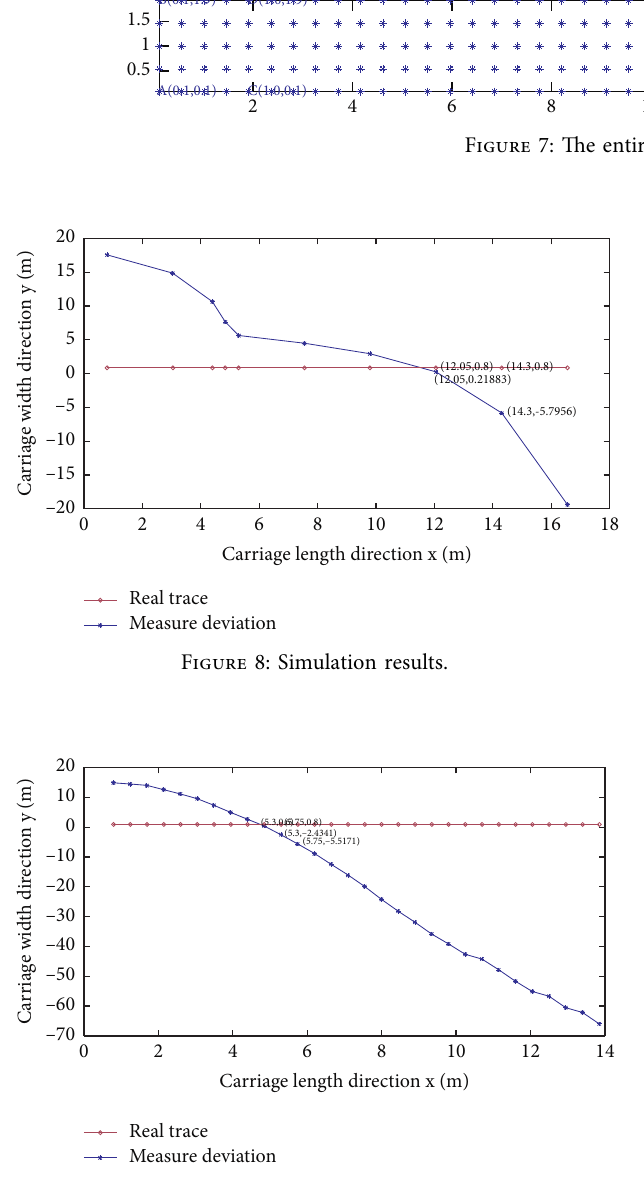
Figure 9: Simulation results at 2.25m/s walking speed at 0.5m/s walking speed.